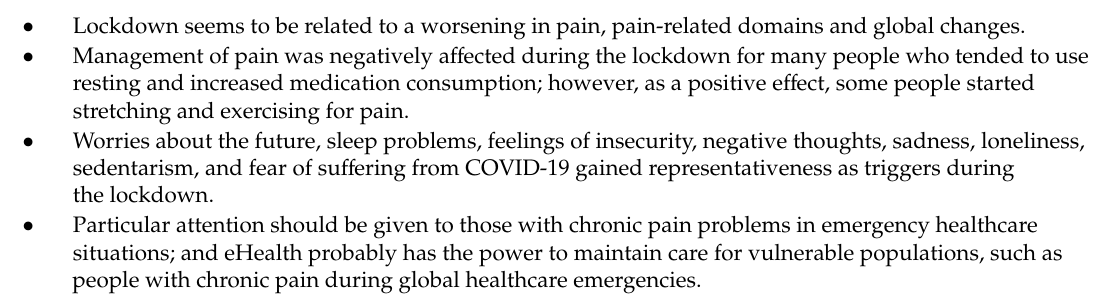
Table 6. Main implications of the